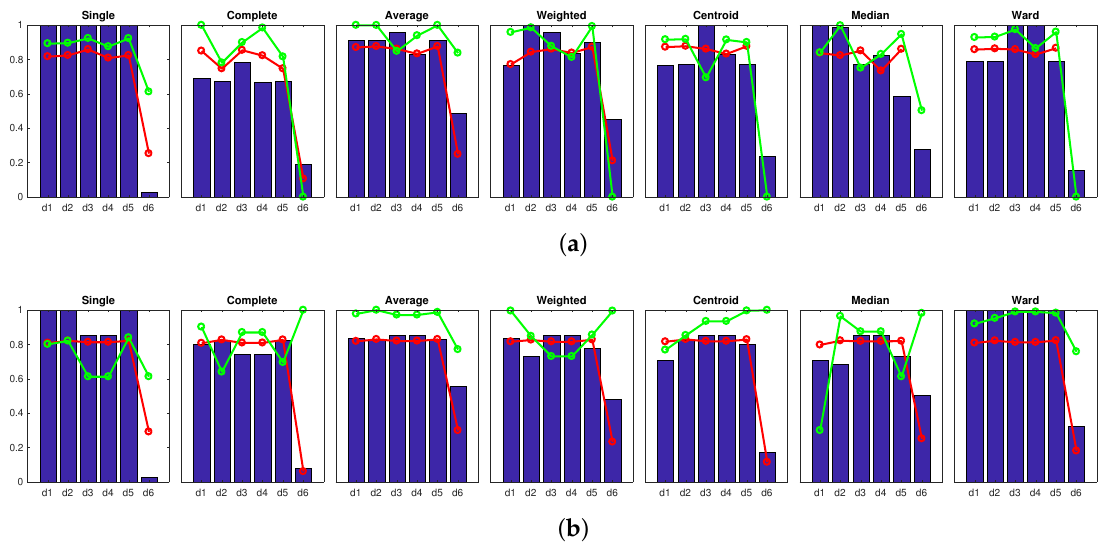
Figure 11. Legend: (cid:4) Accuracy c ; −◦− Correlation γ coph ; −◦− Inconsistency δ inconsist . Results of the high-level clustering using CNN as global-appearance descriptor and ( a ) layer fc7 (4096 components); ( b ) layer fc8 (205